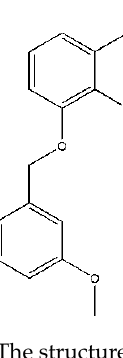
Figure 1. The structure of compound 160a.